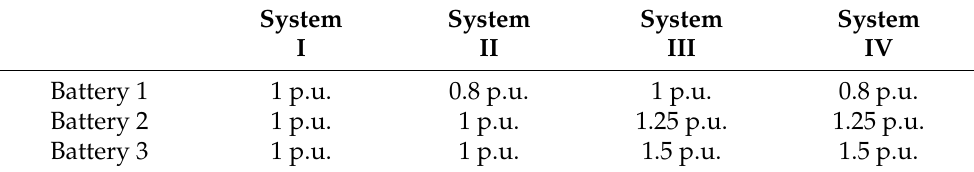
Table 2. Rated energies of the batteries normalized to E 0 in different system configurations.